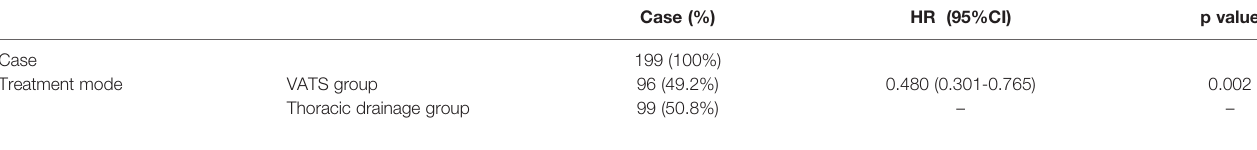
TABLE 2 | Multivariate Cox model for overall survival in all patients.